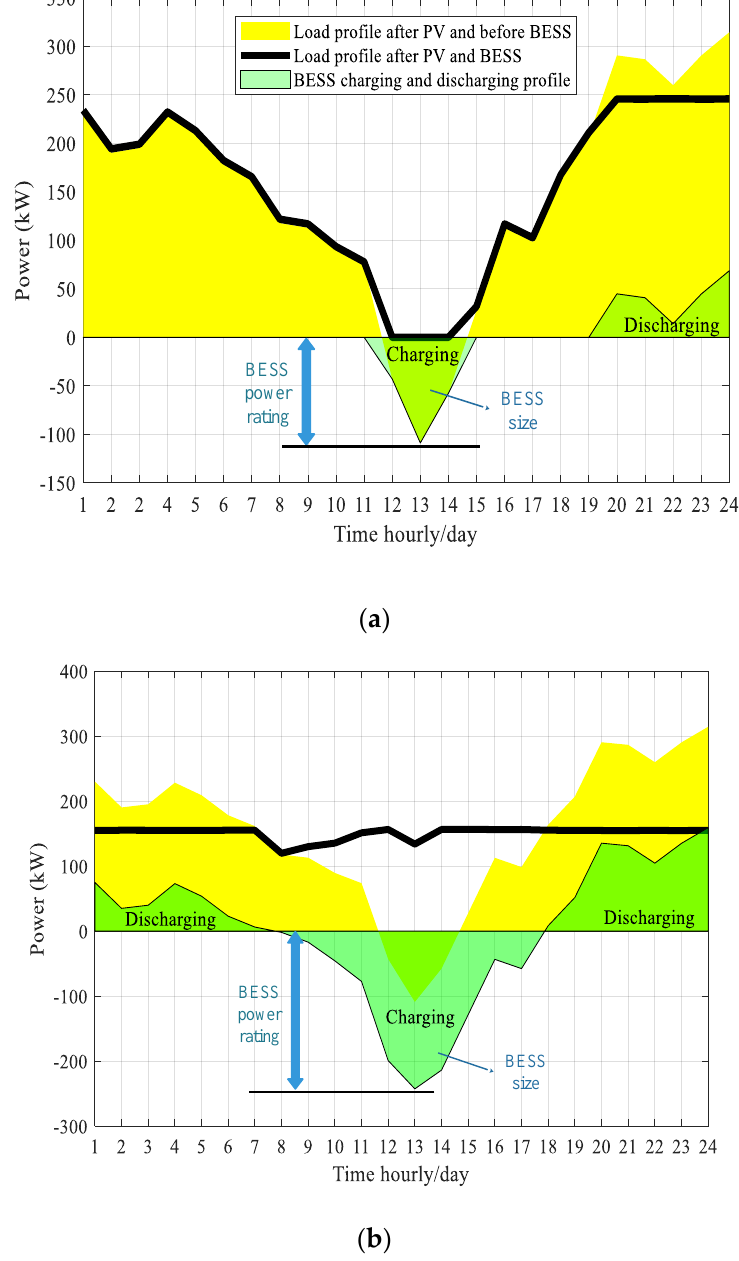
Figure 9. BESS operation for peak reduction strategy (PRS) concept under ( a ) RPFS and ( b ) PVGS. Figure 10 shows the implementation of a rooftop PV system and BESS allocation. The process begins with initial data entry for load and PV profiles for each consumer (149 households) for a one year period with 10 min data intervals (144 samples). The test network under study is modeled in OpenDSS to establish base case characteristics with power flow simulation. The PV system is then integrated to the network with di ff erent penetration levels (25% to 100%). The results of power flow calculation after PV integration are obtained and stored in common-separated values file (CSV) format. The sizing and power rating of BESS are determined based on applied charging and discharging strategies. The obtained results of power flow calculations for before and after BESS, and PV integration are compared with the base case. This is to determine the most e ff ective and adequate BESS sizing for each PV penetration level.